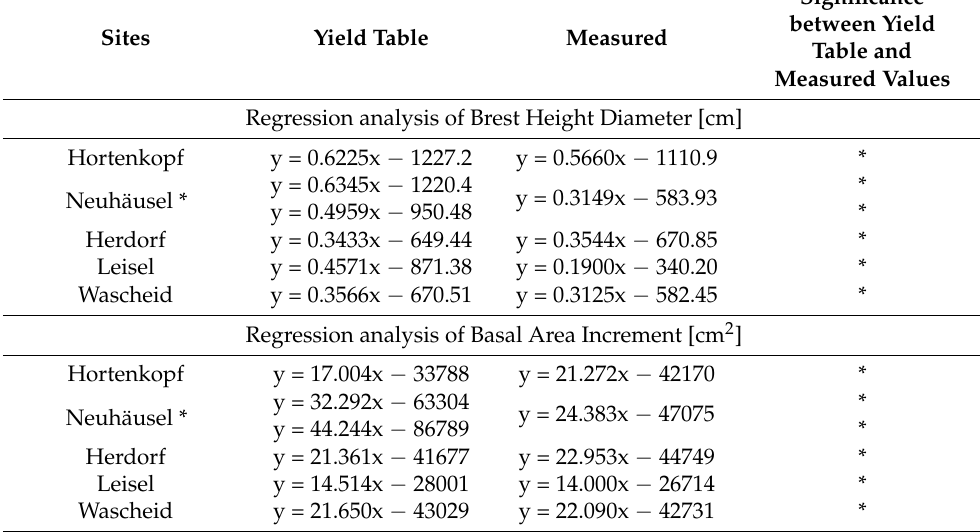
Table 4. Regression analysis of Brest Height Diameter (cm). The regression equations are the result of a trend analysis between BHD or Basal Area Increment (BAI) of the specific age and yield power (site quality class defined by height of dominant trees) which are compared with the regression equation during the same time span of measured DBH or BAI. Afterwards the significance ( p ≤ 0.05) of the slopes was determined using a t-test between the Expected Growth (Yield Table) and the Measured Growth values. Sites Yield Table Measured